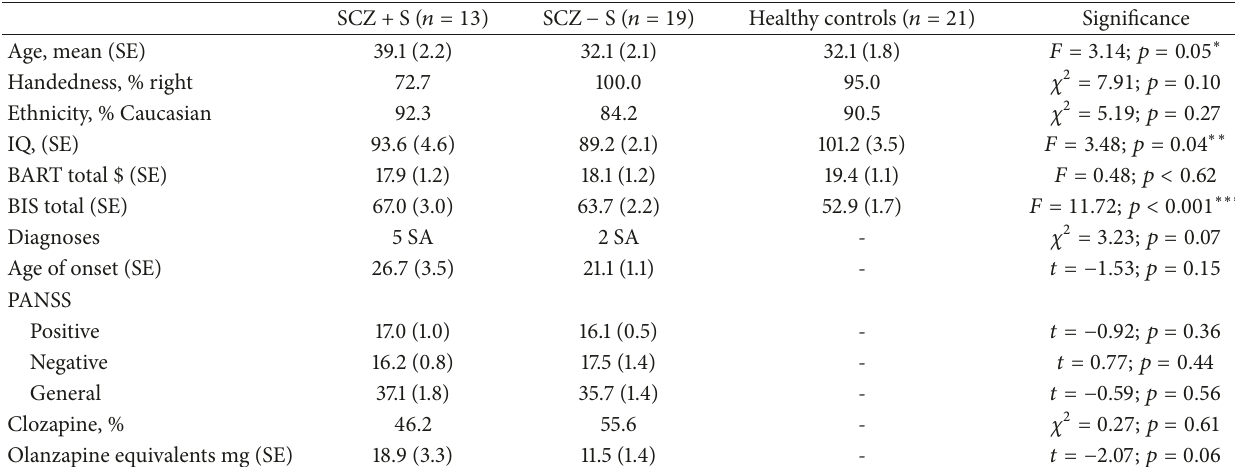
Table 1: Participant